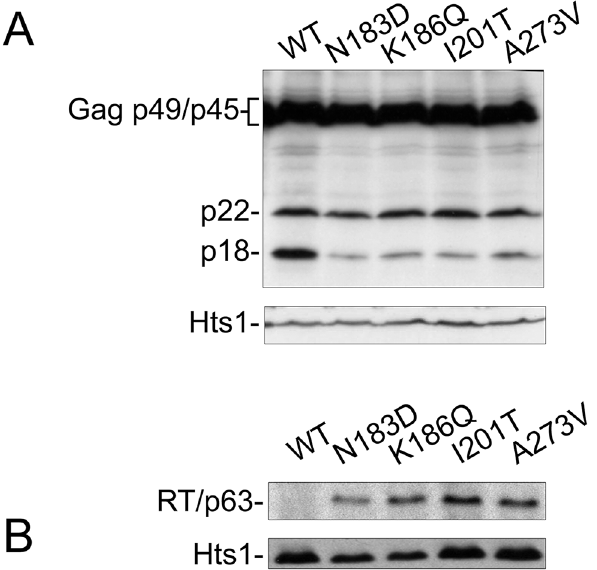
Fig 5. CNC R mutations N183D, K186Q, I201T, and A273V alter Ty1 protein levels. S . paradoxus repopulated with 38 genomic copies of Ty1-H3 (YEM515) containing wild type or CNC R pGTy1 his3-AI plasmids were analyzed for Ty1 protein levels. Cells were induced in liquid SC-Ura + 2% galactose for 24 h. (A) TCA-extracted proteins were immunoblotted with p18 and Hts1 antibodies. (B) Whole cell extracts were immunoblotted with RT and Hts1